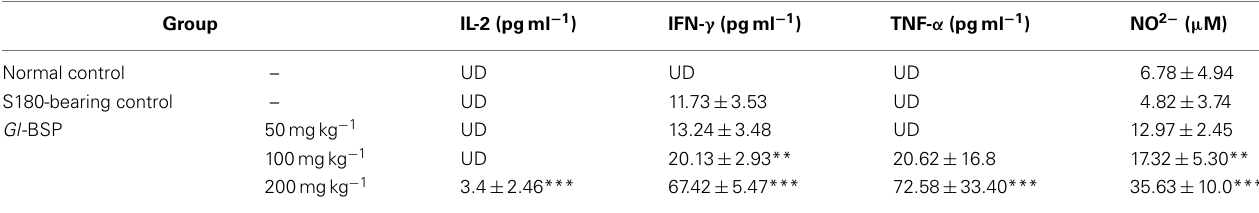
Table 7 | Effect of Gl -BSP on Production of Serum Cytokines and NO in S180-bearing mice ( n = 10, ¯ x ±